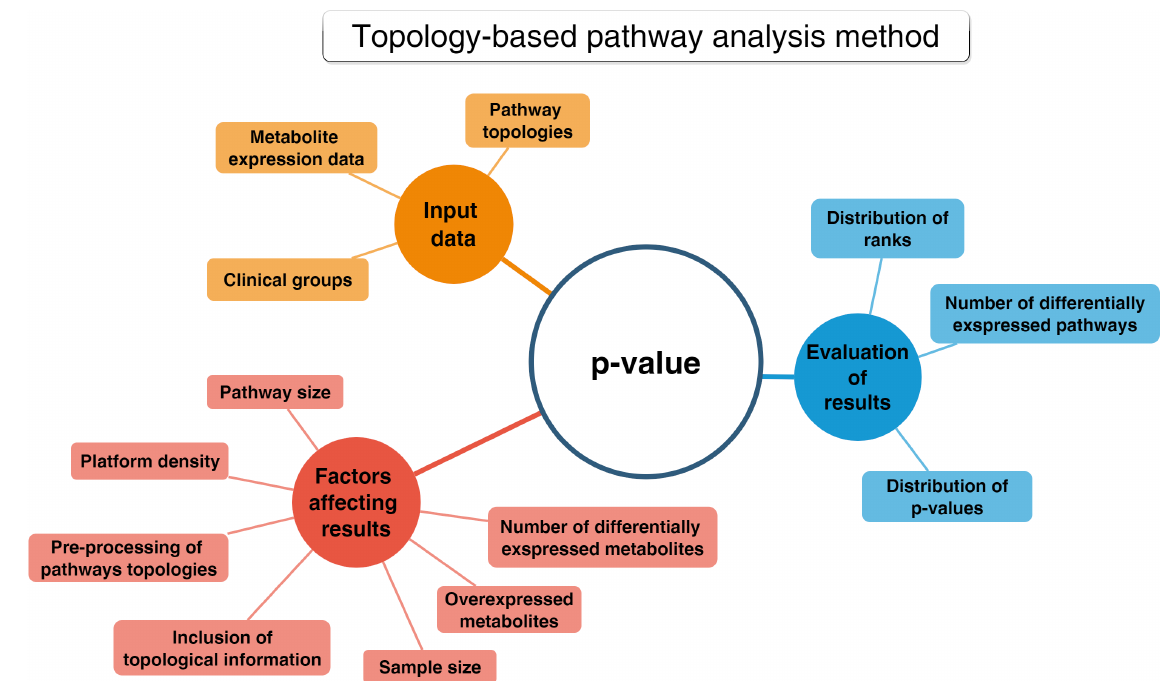
Figure 10. Conceptual map about the topology-based pathway analysis